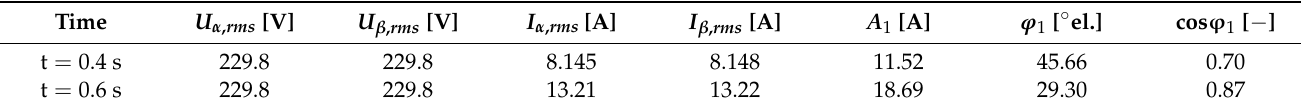
Table 6. Simulation results before and after the change (at steady states).